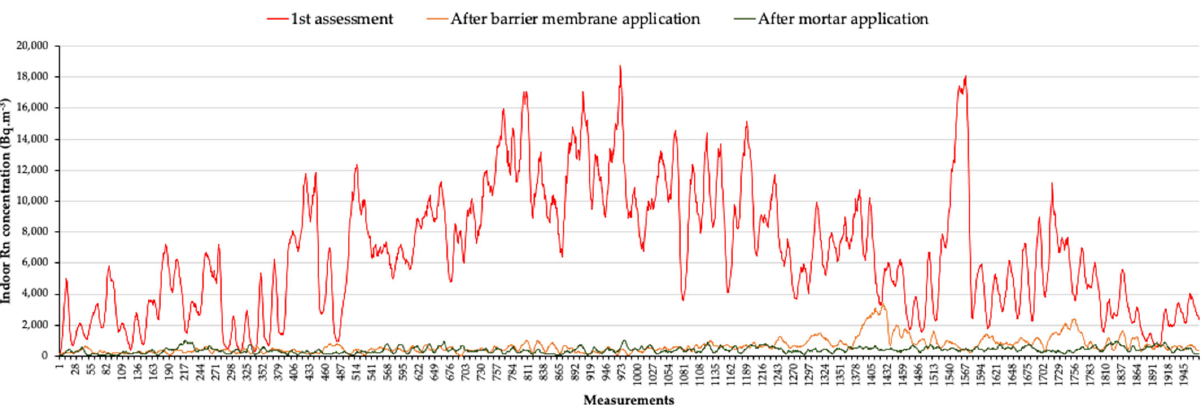
Figure 11. Evolution of the data collected in the different indoor Rn concentration monitoring phases.